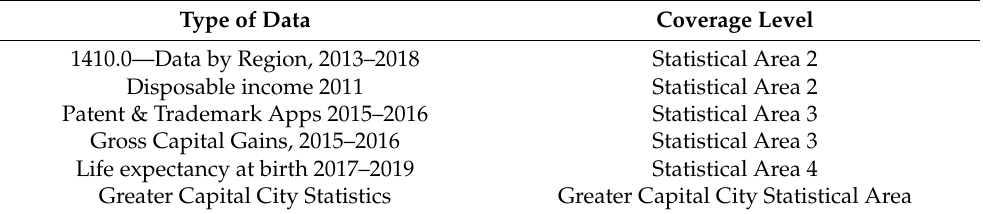
Table 2. Data Source for analysis.